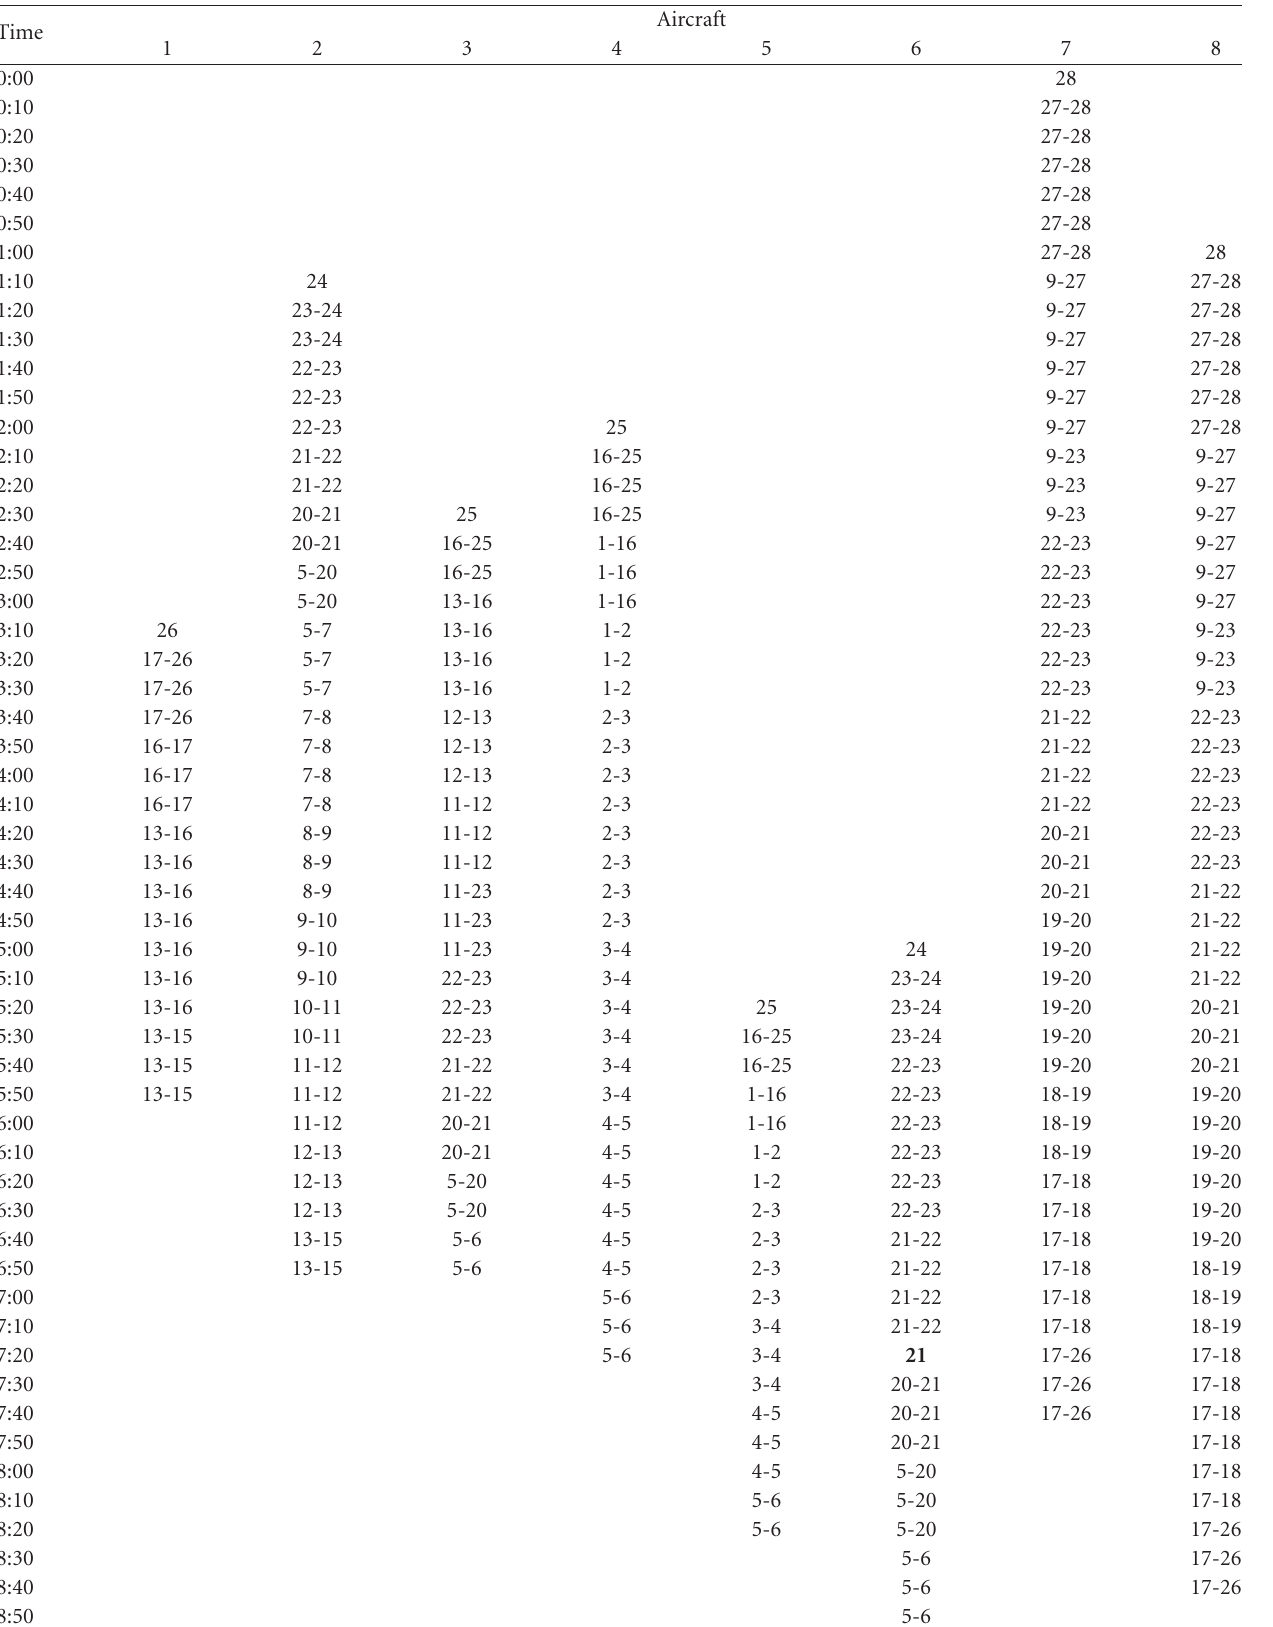
Table 5: Planning update after 2 minutes